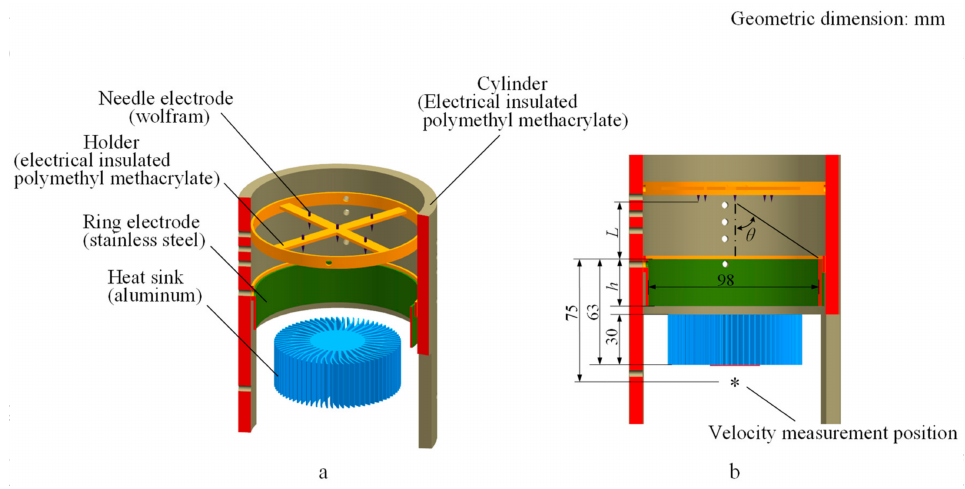
Figure 1. Ionic wind device: ( a ) structure of the device; and ( b ) some dimensions of the device.